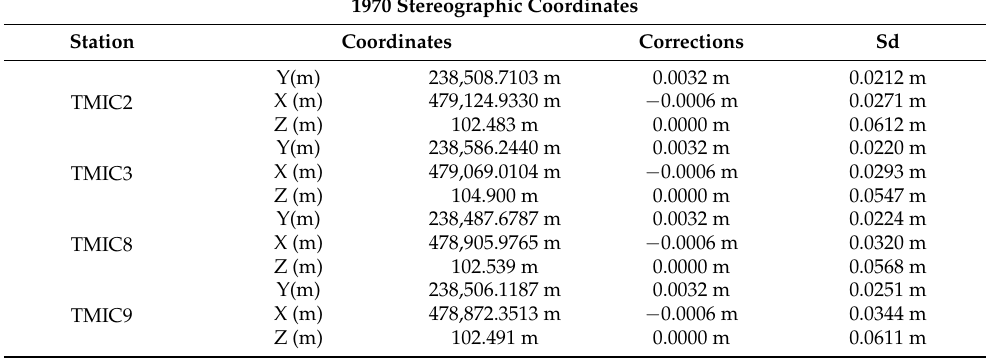
Table 10. 1970 Stereographic coordinates obtained by CINEMATIC measurements (RTK).